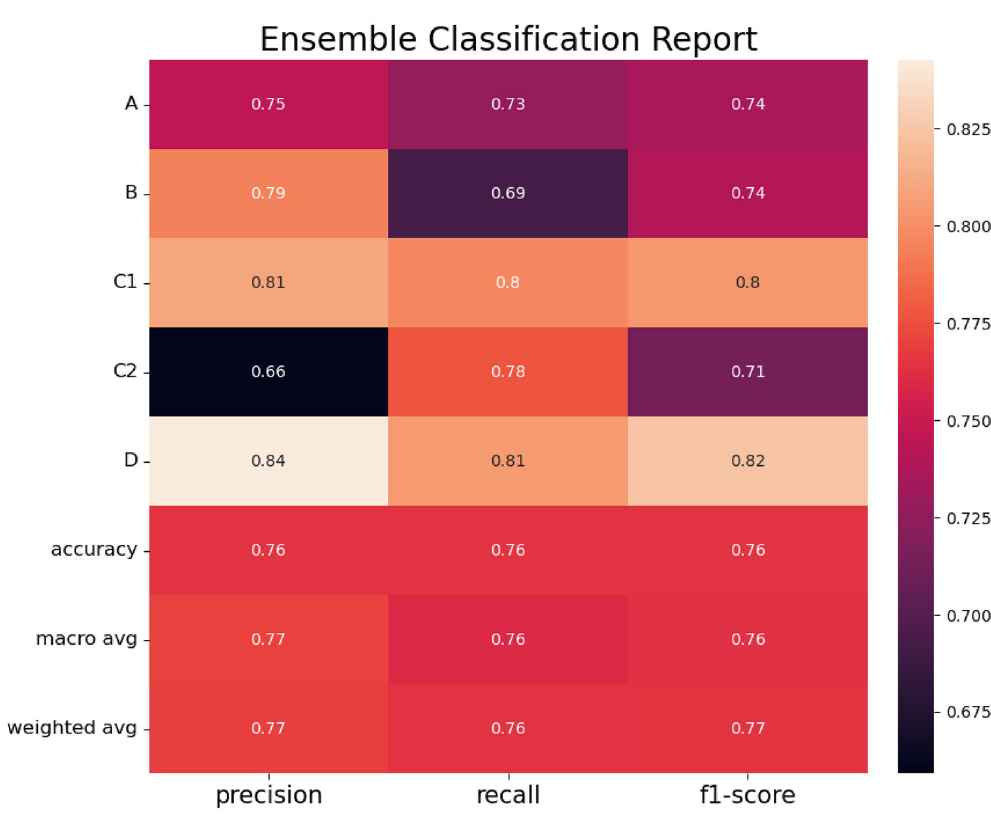
Figure 7. Ensemble classification report for 1-D CNN with attention model